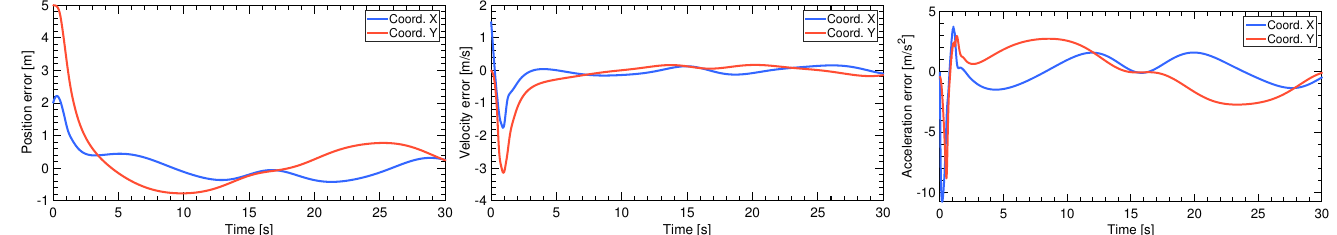
Figure 22. Trajectory following test (circular path) in case of incorrect knowledge of resistance coefficients: position error ( left ), velocity error ( middle ), and acceleration error ( right